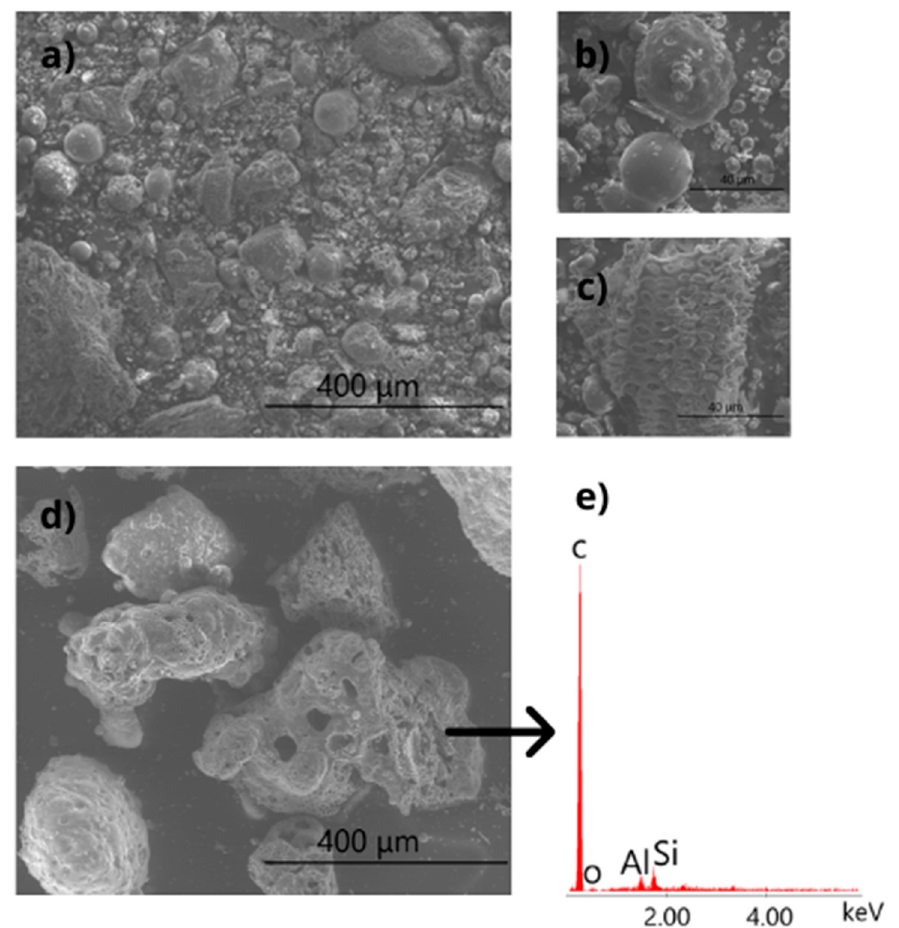
Figure 1. Fly ash microphotography ( a ), microsphere microphotography ( b ), unburned carbon microphotography ( c ), screened residue microphotography ( d ), EDS spectroscopy of residue ( e